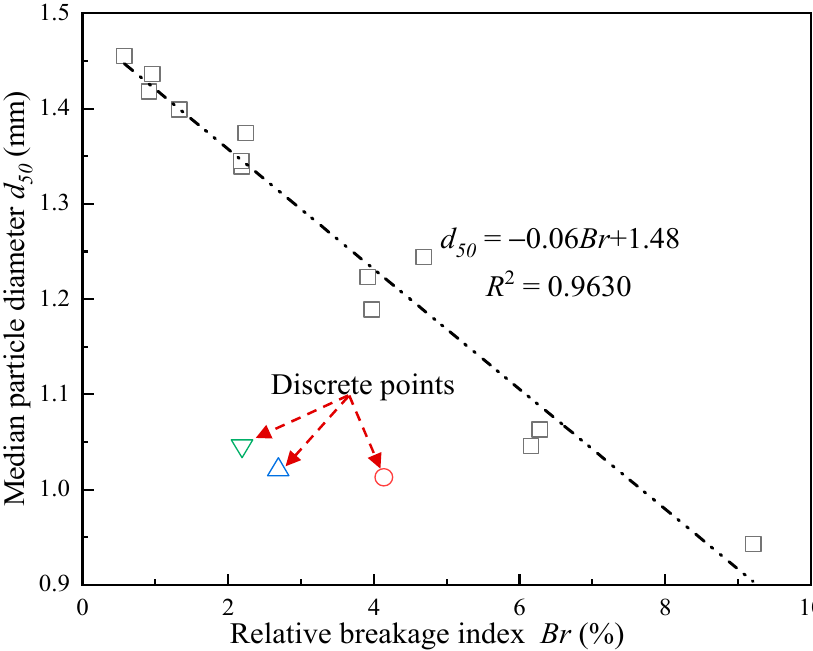
Figure 12. The relationship between median particle diameter and relative breakage index.